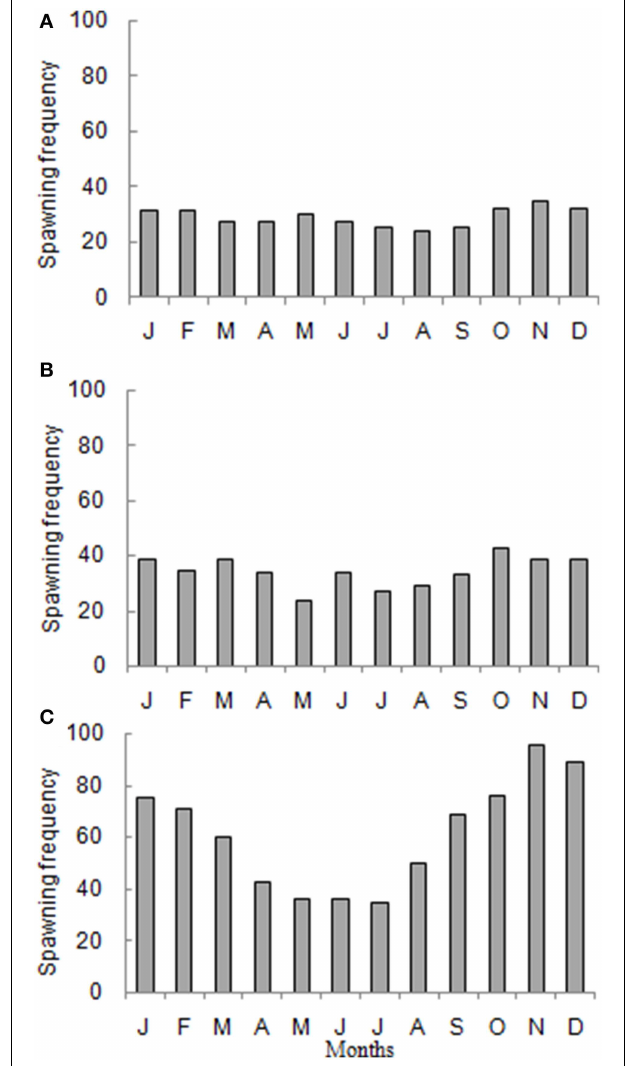
FIGURE 6 | Percentage frequency of the number of species in spawning activity in each month for marine fishes in (A) North Brazil Shelf, (B) East Brazil Shelf, and (C) South Brazil Shelf.